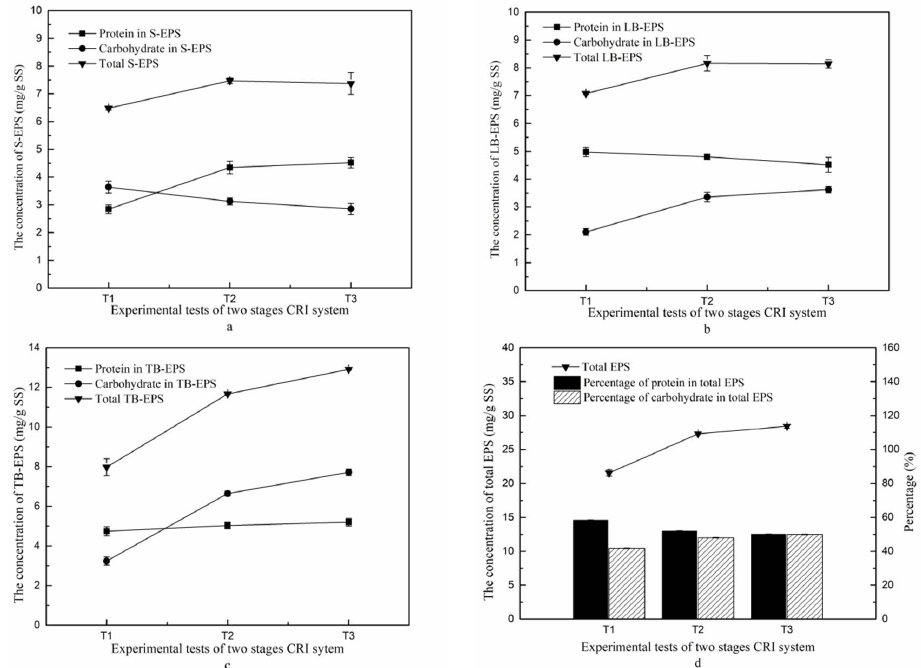
Figure 8. The concentrations of EPS (triangles), and its protein (squares) and carbohydrate (circles) fractions (all expressed as mg/g SS) in the sand of the second stage system. ( a ) S-EPS; ( b ) LB-EPS; ( c ) TB-EPS; ( d ) Total EPS. The percentages of protein and carbohydrate fractions in total EPS are also shown as bars in ( d ).